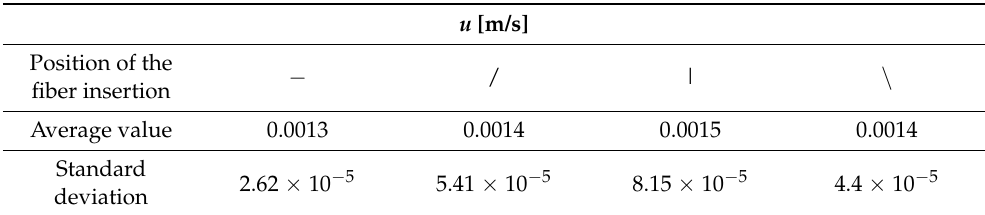
Table 1. Example of settling velocity of fibers depending on their position during hindered settling in glycerine with a constant temperature.